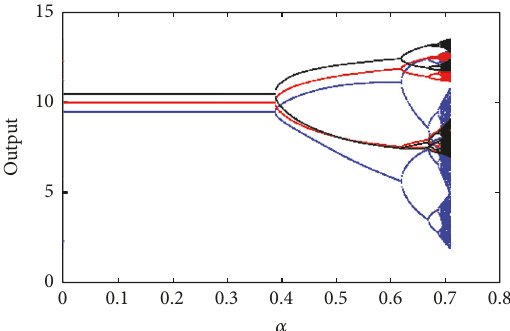
Figure 21: Bifurcation diagram with 𝛼 , 𝑘 = 1 .